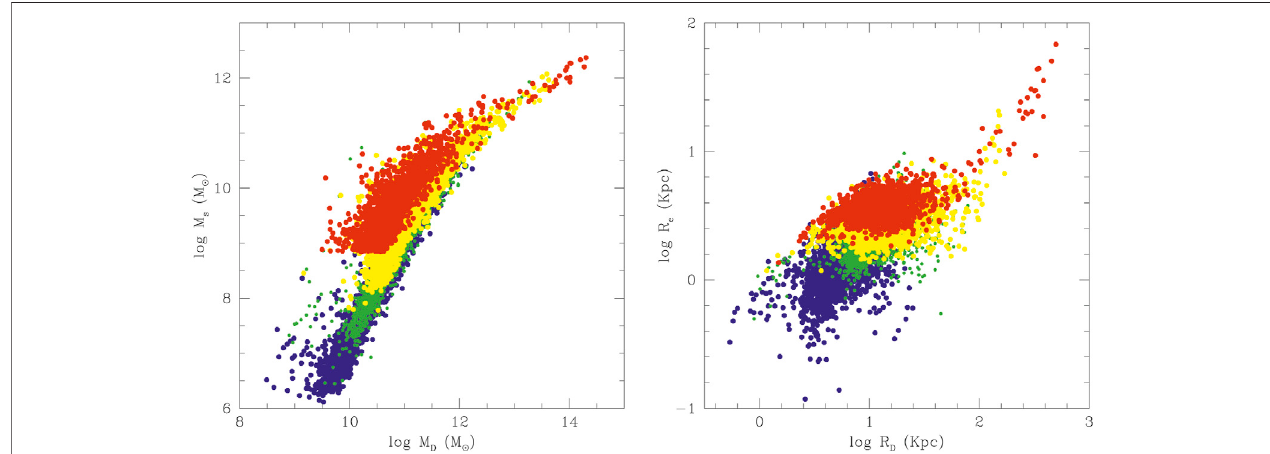
FIGURE9|Leftpanel: The M s − M D relationsatdifferentredshifts( z (cid:1) 4,blue; z (cid:1) 2,green; z (cid:1) 1,yellow; z (cid:1) 0,red).Massesareinsolarunits.Thesolidlinesarethe best fi ts discussed in the text. Right panel: the same as in the left panel but for the R e − R D relations. Radii are in kpc.